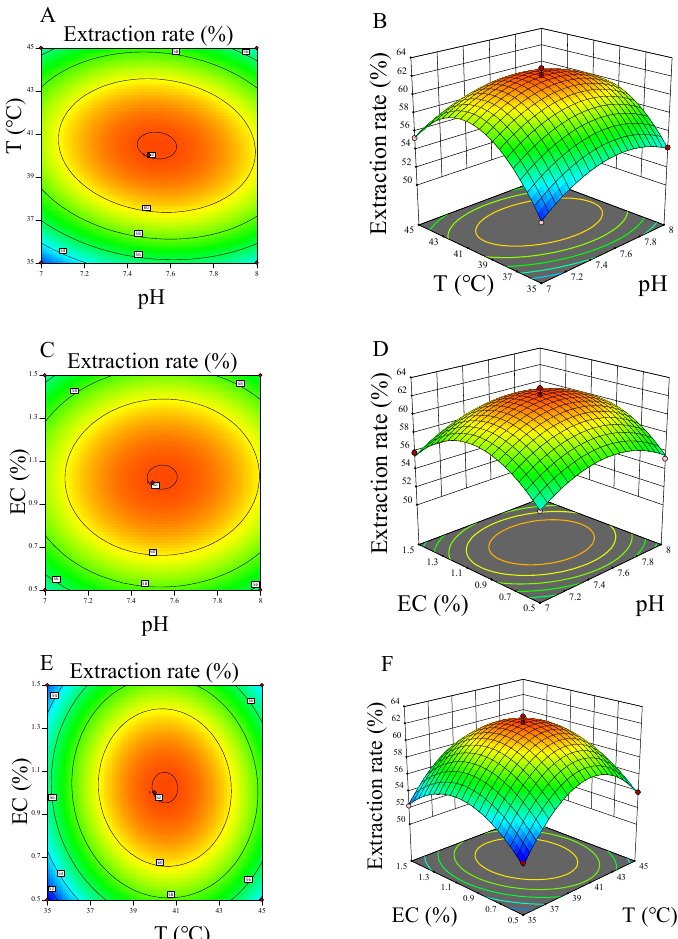
Figure 4. Response surface plots showing the effects of T (temperature), extraction pH, EC (enzyme concentration) on the WBY polypeptide extraction. ( A , B ) effect of interaction between T and extraction pH; ( C , D ) effect of interaction between EC and extraction pH; ( E , F ) effect of interaction between T and EC.